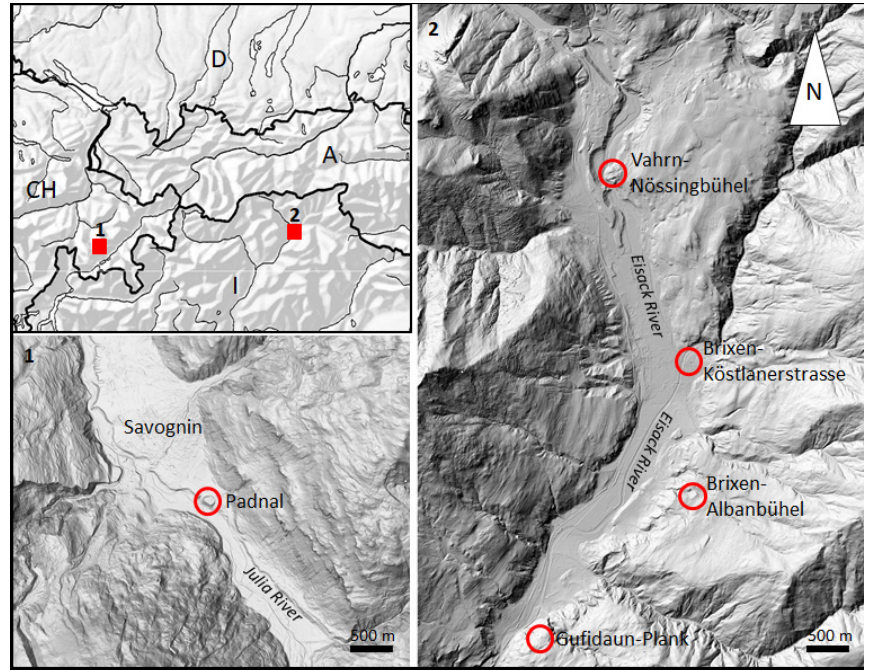
Figure 1. Topographical maps showing an overview and details of the locations of the sites in Switzerland (1) and South Tyrol, Northern Italy (2). ©swisstopo; Thomas Reitmaier Archaeological Service of the canton Grison, Switzerland, and Klaus Oeggl University of Innsbruck.